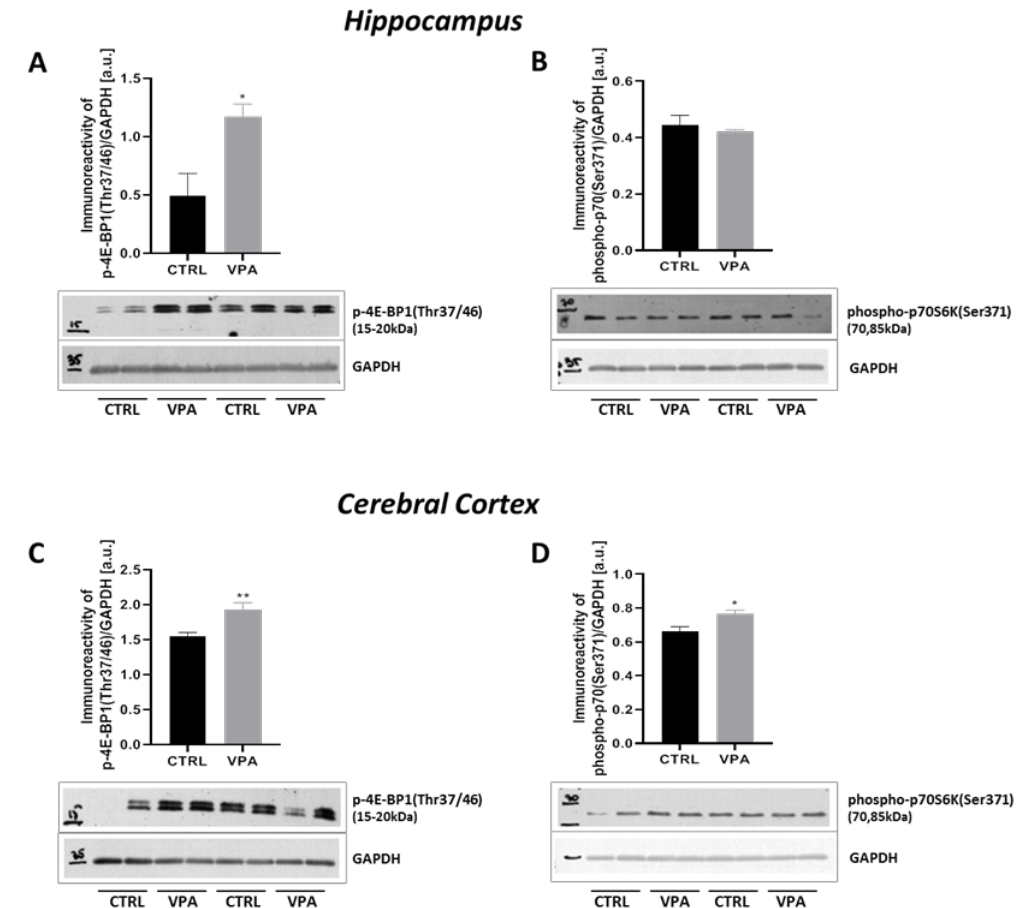
Figure 15. The effect of prenatal exposure to VPA on the mTOR downstream effectors: 4E-BP1 and p70S6K in the rat brain. Immunoreactivity of p-4E-BP1(Thr37/46) and phosho-p70S6K(Ser371) were determined using Western blot analysis. Representative blots and densitometric analysis of p-4E-BP1(Thr37/46) and p70S6K phosphorylated at (Ser371) in the hippocampus ( A , B ) and cerebral cortex ( C , D ) were shown. Results were normalized to GAPDH levels. Data represent the means ± S.E.M. from n = (3–4) independent experiments in the hippocampus: ( A ) n = 3 (CTRL), n = 4 (VPA); ( B ) n = 4 (CTRL), n = 4 (VPA); and n = (4–8) in the cerebral cortex: ( C ) n = 7 (CTRL), n = 8 (VPA); ( D ) n = 4 (CTRL), n = 4 (VPA). * p < 0.5, ** p < 0.01, vs. control.